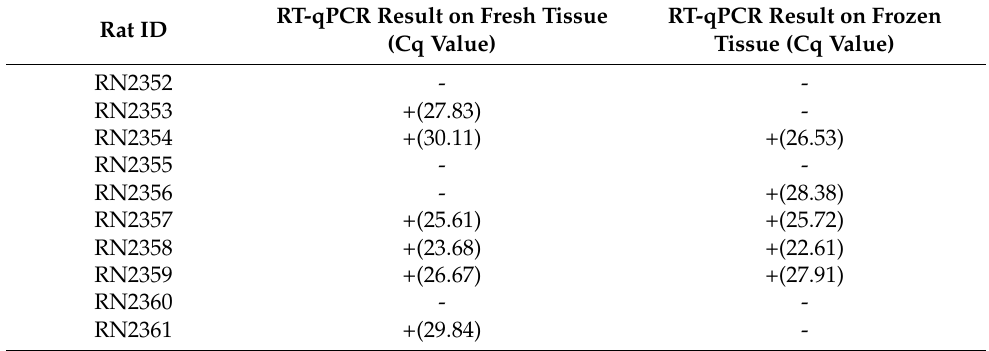
Table 3. Comparison of SEOV RT-qPCR results on fresh versus frozen lung tissue from ten